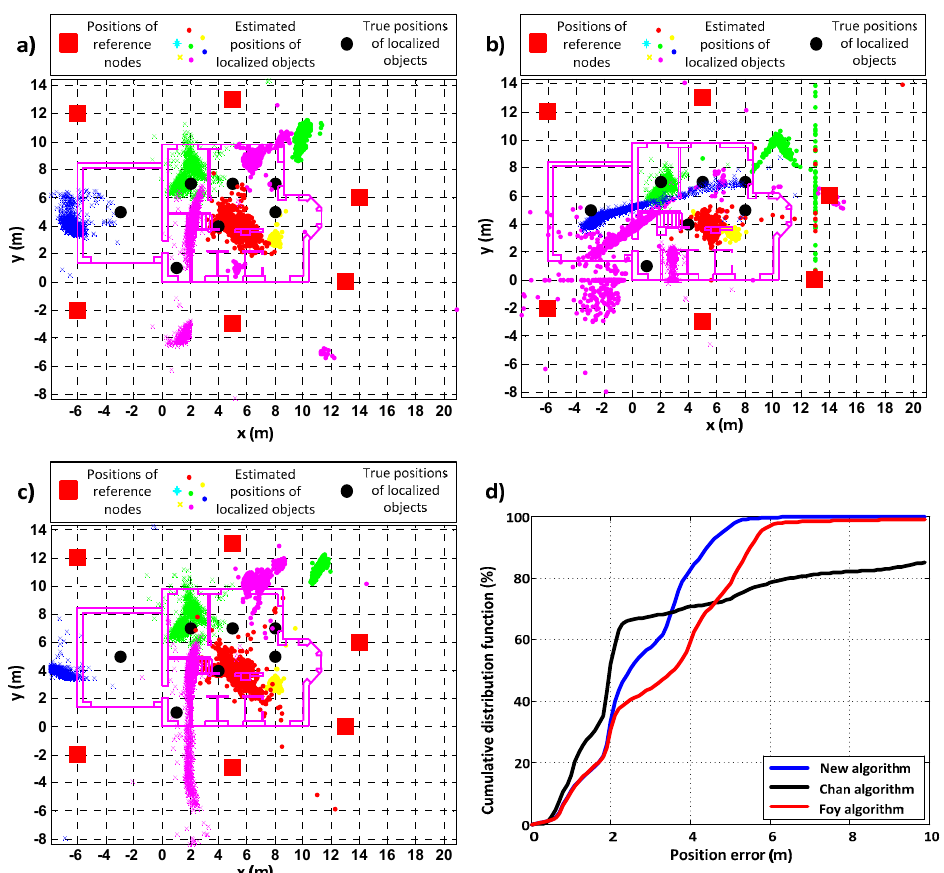
Figure 9. Comparative analysis of the performance of ( a ) the new algorithm, ( b ) the Chan algorithm, ( c ) the Foy algorithm, and ( d ) the cumulative distribution functions of position errors when PIMs were placed on the first floor of an un-inhabited single-family house and reference nodes (RNs) were deployed outside it. Table 4. Results of comparative analysis when PIMs were placed on the first floor of un-inhabited single-family house and RNs were deployed outside it.